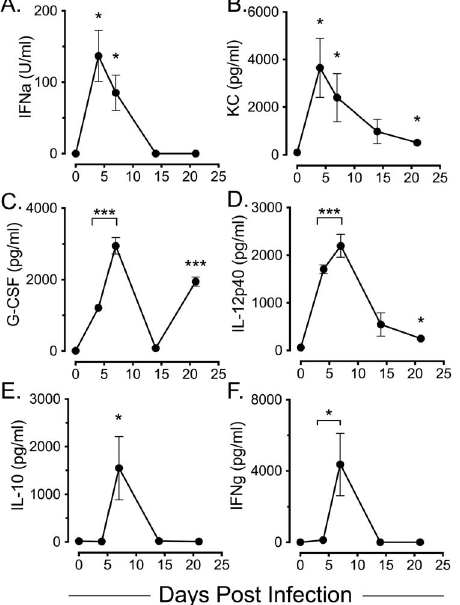
Figure 3. BALF cytokine analysis following IAV infection. Mice were infected with IAV i.n. and BALF fluids harvested at the indicated time points and assessed for (A) IFN a by bioassay as described in Materials and Methods, and by multiplex immunoassay assay for (B) KC, (C) G-CSF (D) IL-12 p40, (E) IL-10 and (F) IFN c . Results shown are means + / 2 SEM of duplicate samples for 3 mice at each time point. Statistical significances were calculated for infected mice relative to control (d0) mice. * = p , 0.05; *** = p ,